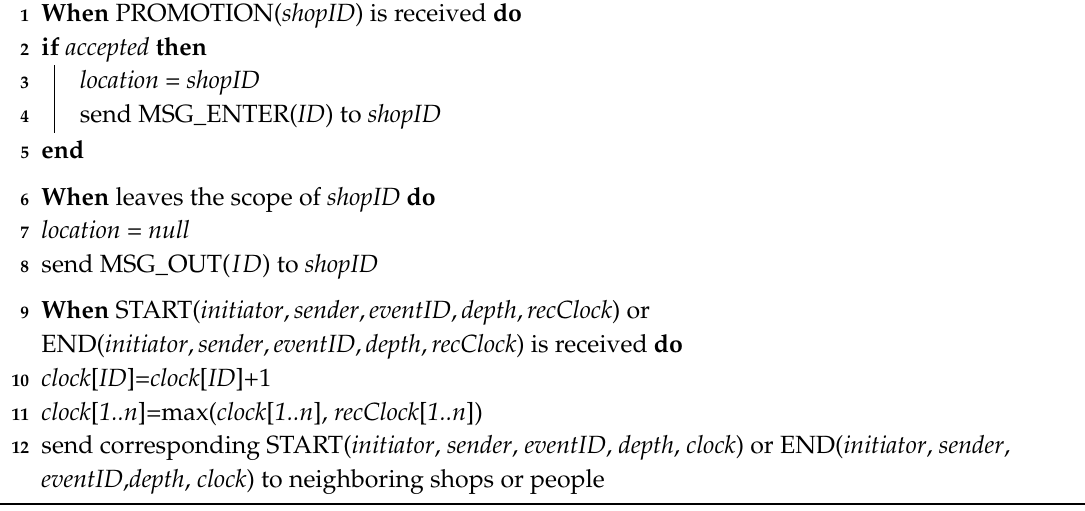
Algorithm 1: Asynchronous Distributed Data Collection Approach